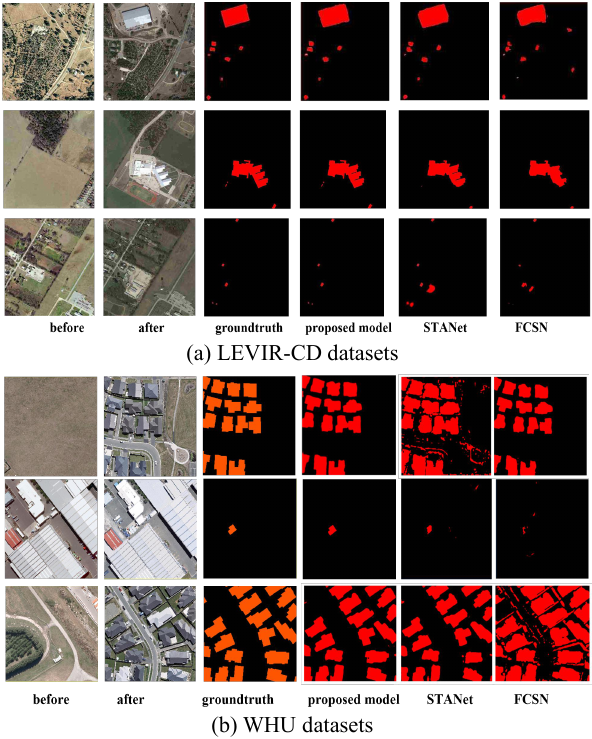
Figure 5 . buildings change detection results compared to